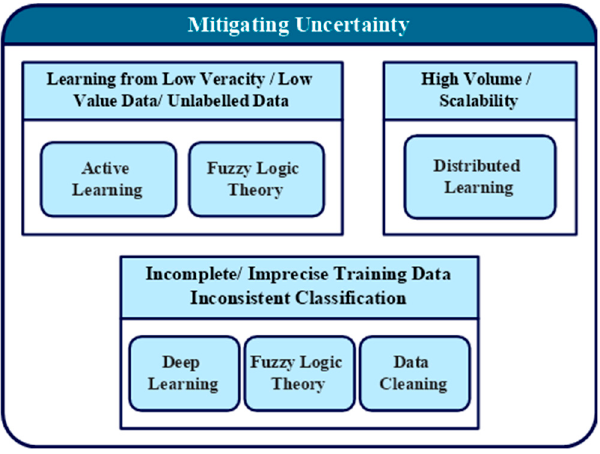
Figure 5. Uncertainty mitigation strategies (Source: [36]).